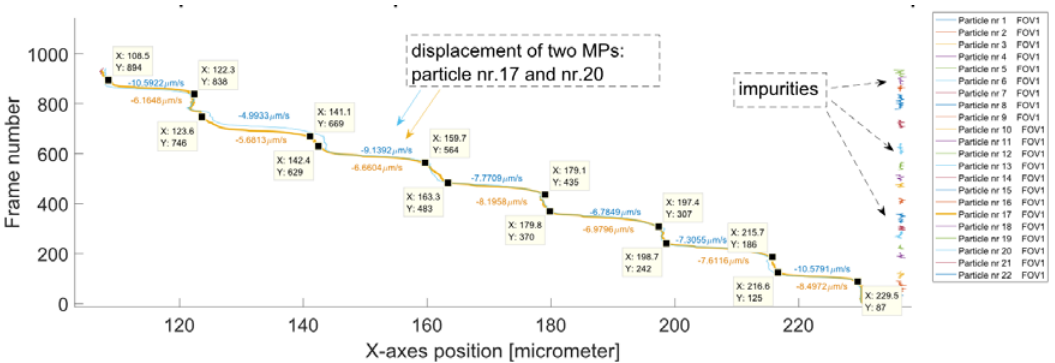
Figure 11. For MLBs with known concentration of 2 × 10 3 CFU/mL: the displacement of tracked particles over the sequence of frames. There are two characteristic manipulations of MLBs: MLB Nr. 17 (yellow) and MLB Nr. 20 (blue). The rest of the tracked particles are impurities (on the right) and can be clearly differentiated from MLB.